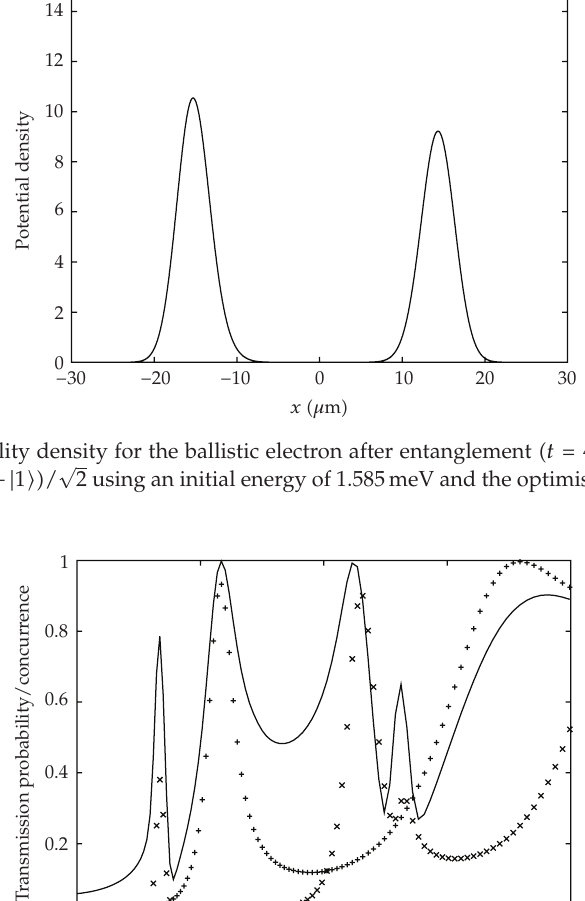
Figure 7: The concurrence of the system for the qubit in the | (cid:8) (cid:2) (cid:7) (cid:9) | 0 (cid:2) (cid:8) | 1 (cid:2) (cid:10) / the transmission probabilities associated with the | 0 (cid:2) (cid:9)(cid:8)(cid:10) and | 1 (cid:2) (cid:9) × (cid:10) qubit states over a range of ballistic electron energies and with optimized barrier